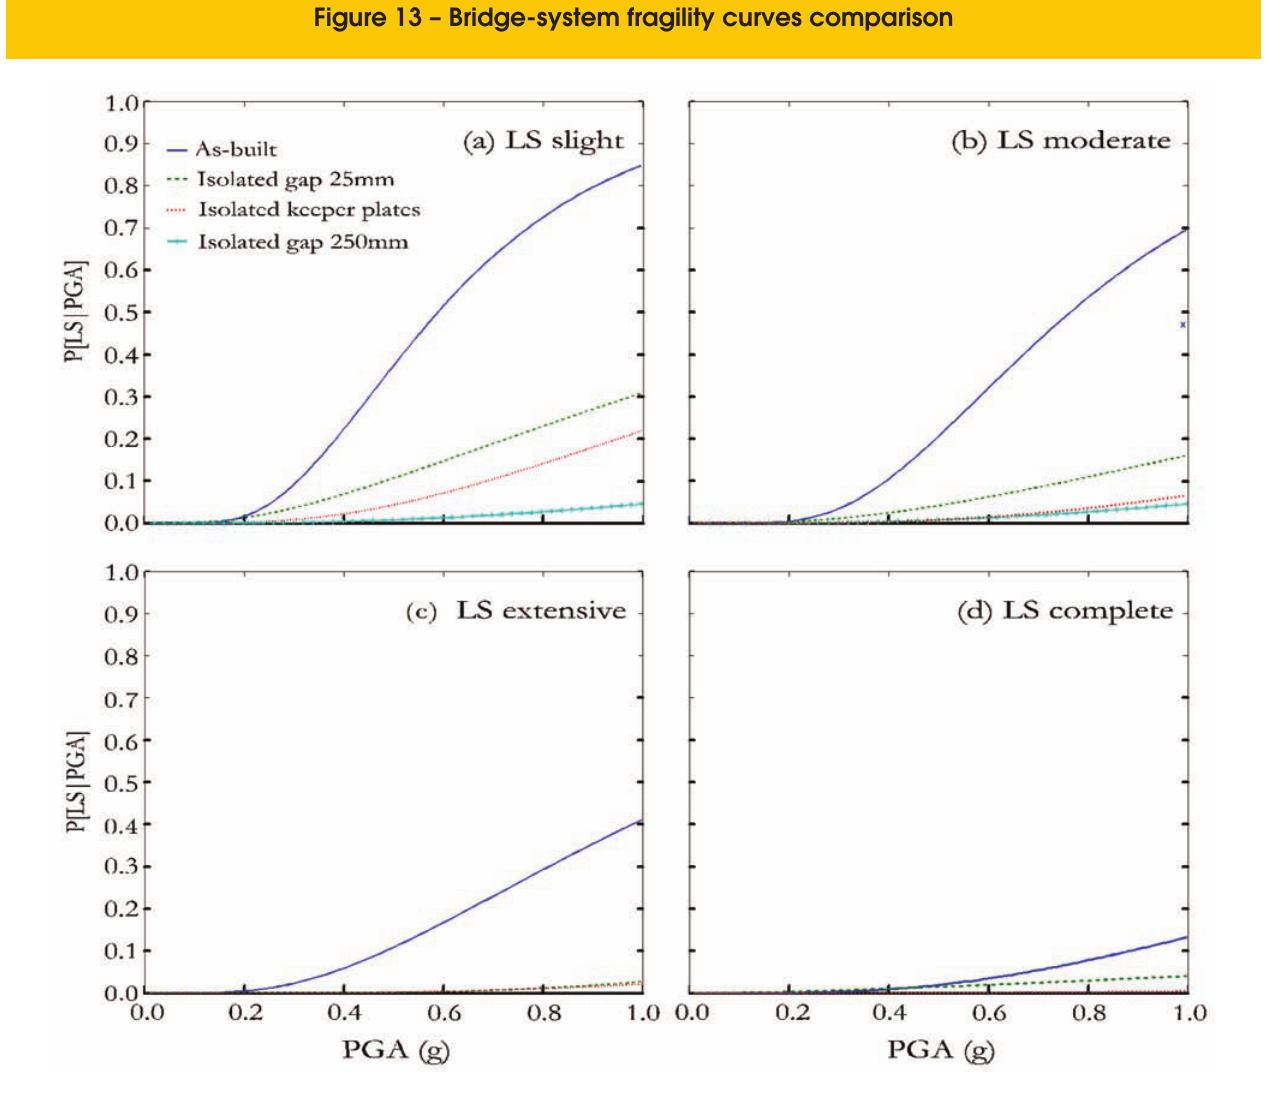
Figure 13 – Bridge-system fragility curves